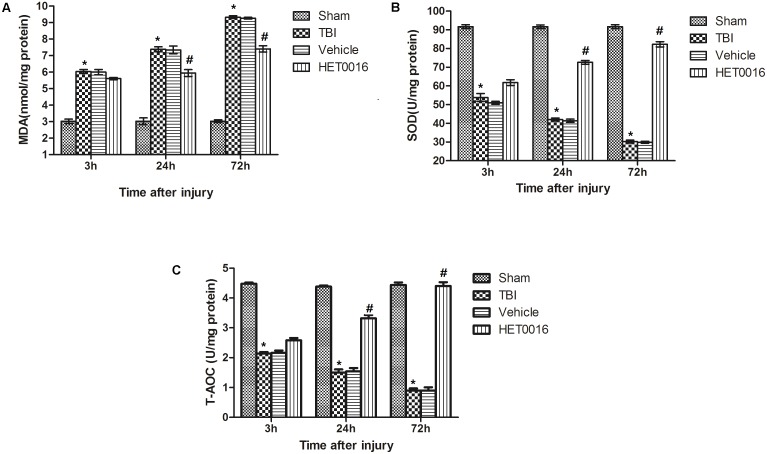
The effect of HET0016 on malondialdehyde (MDA) content and the activity of superoxide dismutase (SOD) and total antioxidative capability (T-AOC) in the traumatic brain tissue after TBI. (A) MDA content in the sham, TBI, vehicle and HET0016-treated groups at 3, 24, and 72 h after injury. (B) The activity of SOD in the sham, TBI, vehicle and HET0016-treated groups at 3, 24, and 72 h after injury. (C) T-AOC in the sham, TBI, vehicle and HET0016-treated groups at 3, 24, and 72 h after injury. Data are shown as the mean ±SD. ∗P < 0.05 compared with the corresponding sham group at the same time point; #P < 0.05 compared with the vehicle-treated group.